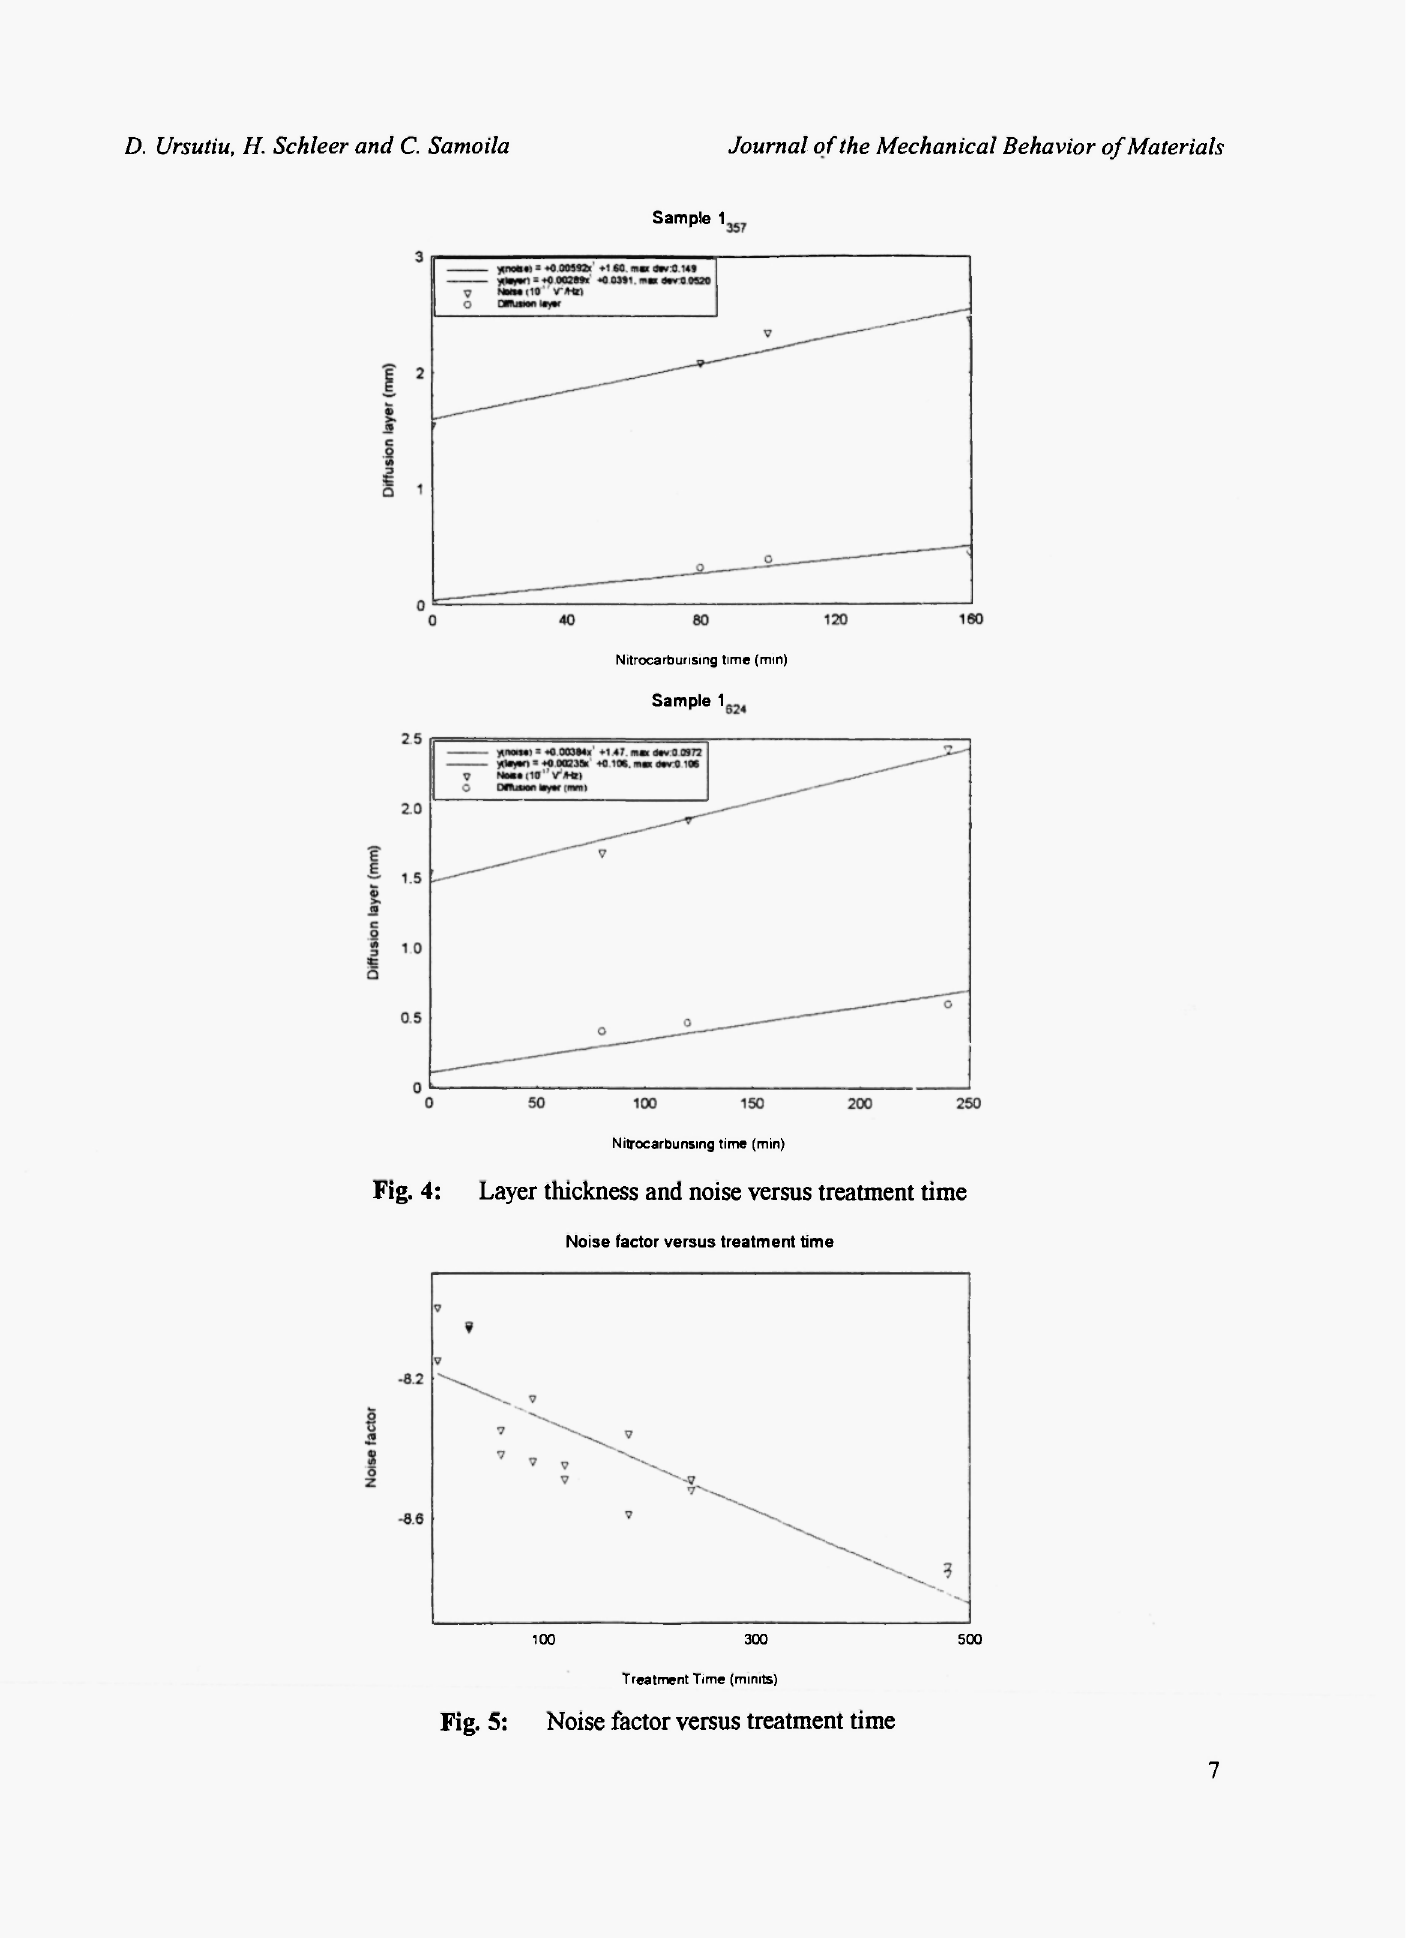
Fig. 4: Layer thickness and noise versus treatment time